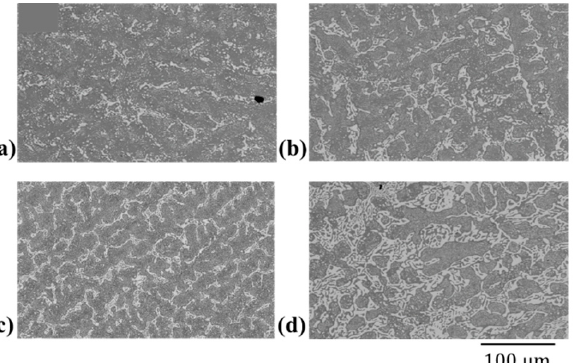
Figure 12. SEM cross-sections of Sn-Bi alloys ( a ) Sn-20 wt.% Bi ( b ) Sn-30 wt.% Bi ( c ) Sn-35 wt.% Bi ( d ) Sn-47 wt.% Bi. Scale bar with 100 µm applies to all images.